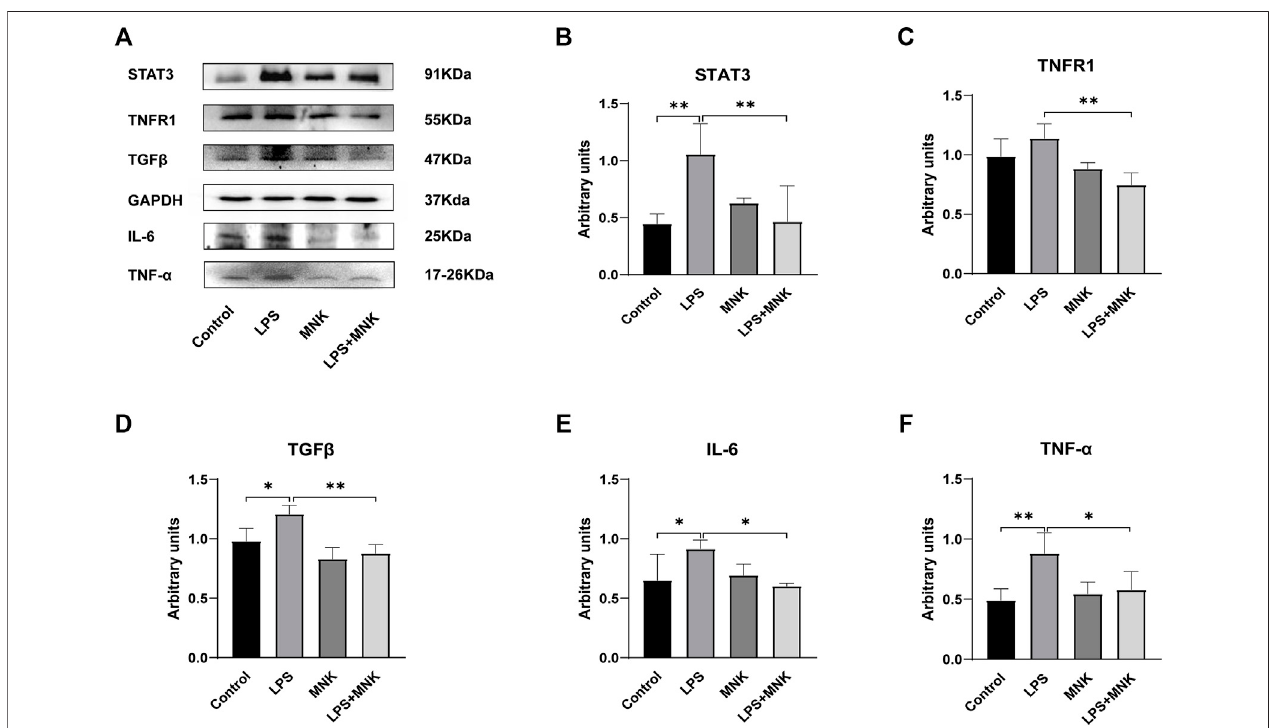
FIGURE 5 | Effect of 2-methyl nonyl ketone (MNK, 10 μ g/ml) on the expression levels of in fl ammation-related proteins in lipopolysaccharide (LPS, 100 μ g/ml)- induced MAC-T cells. (A) The expression of the in fl ammation-related protein was measured using Western blot. (B) Relative levels of signal transducer and activator of transcription (STAT3) were analyzed by grey scanning. (C) TNF-receptor-associated complexI (TNFR1). (D) Transforming growth factor beta (TGF β ). (E) Interleukin (IL)- 6. (F) Tumor necrosis factor- α (TNF- α ). GAPDH was used as an internal reference for Western blotting analysis. The data are shown as mean ± SD. N (cid:1) 3. *, p < 0.05; **, p < 0.01.